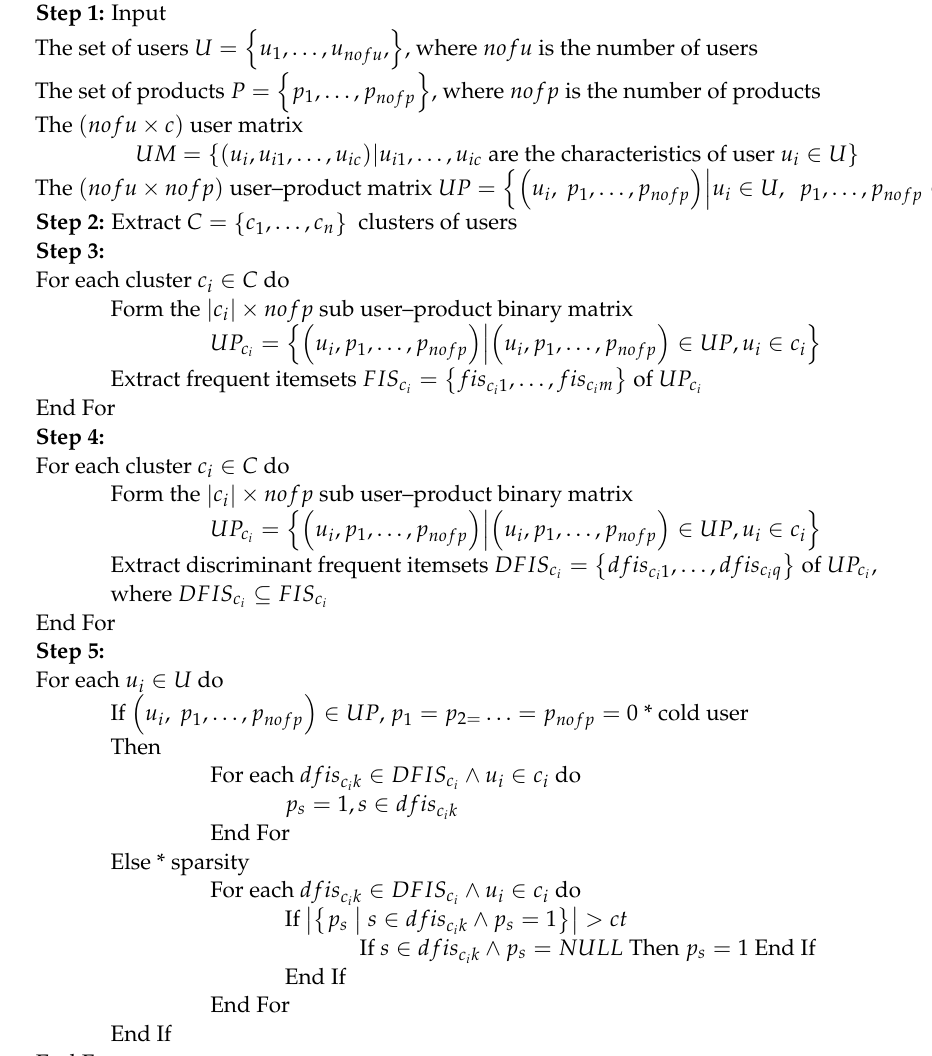
Algorithm1: Recommendation Algorithm based on Discriminant Frequent